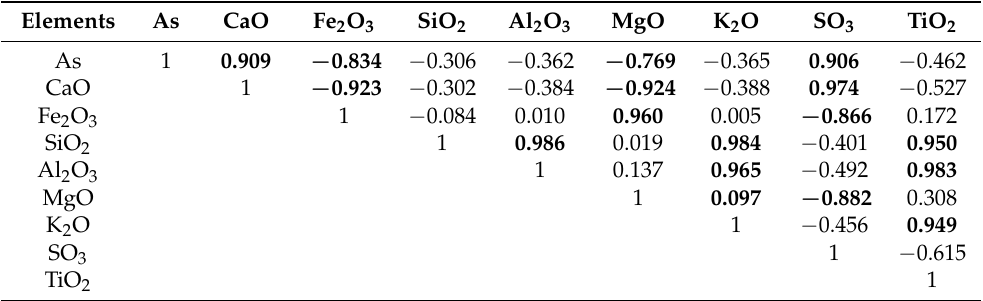
Figure 4. Enrichment factors of As, CaO, S ( a ), and Fe 2 O 3 ( b ) in magnetic fractions (vs. non-magnetic residues). Table 4. Correlation matrix calculated from the concentrations of the target elements in 9 fractions (statistically significant values are highlighted in